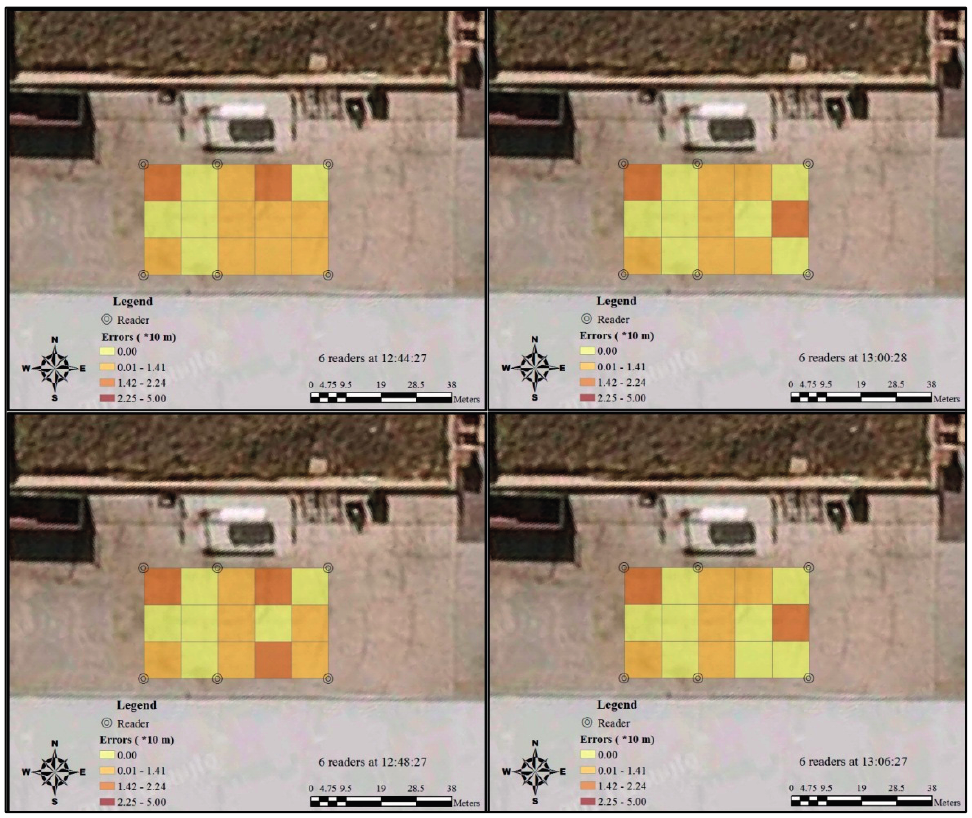
Figure 6. Temporal variation of RFID error distribution in the discrete grids by six